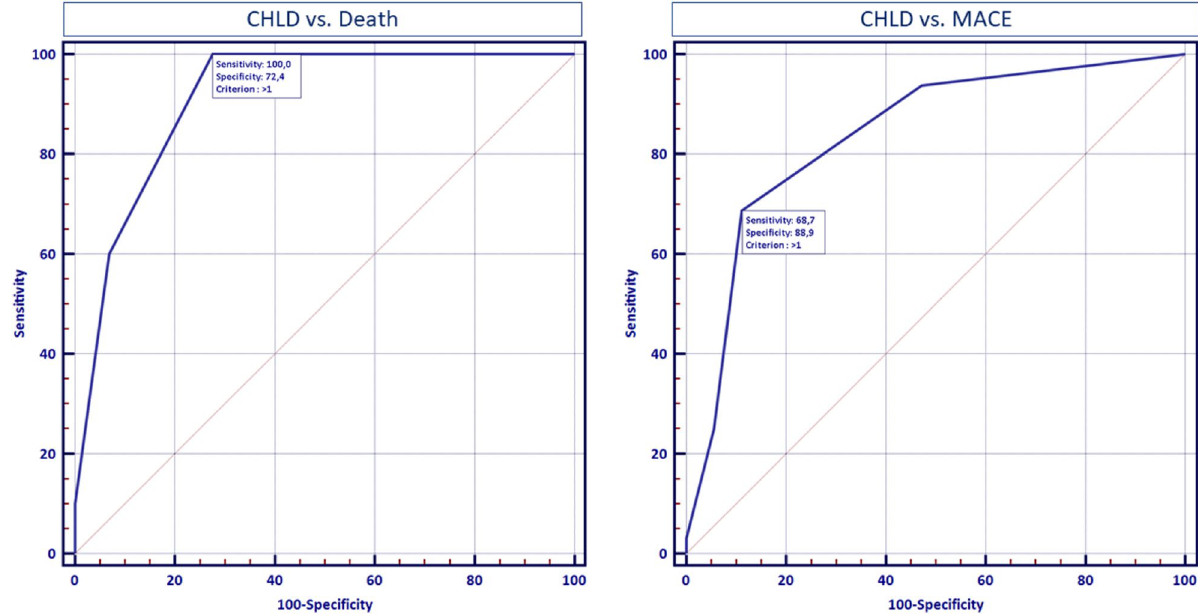
Figure 1. Receiver operating characteristics curve of application of CHLD score for prediction of death and major adverse cardiovascular events. CHLD score: C-chronic kidney disease-1 pt; H: arterial hypertension-1